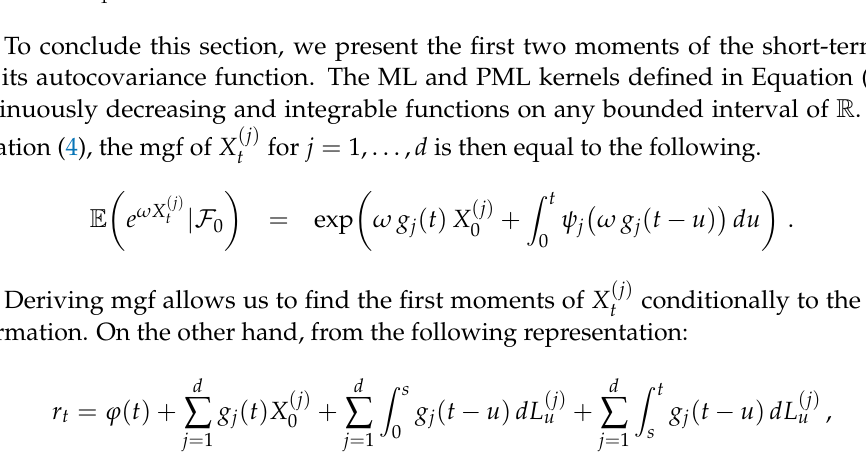
with Mittag–Leffler (ML) t ≥ 0 ( 1 ) = 0, ϕ ( t ) = 0 and L t are Brownian 0